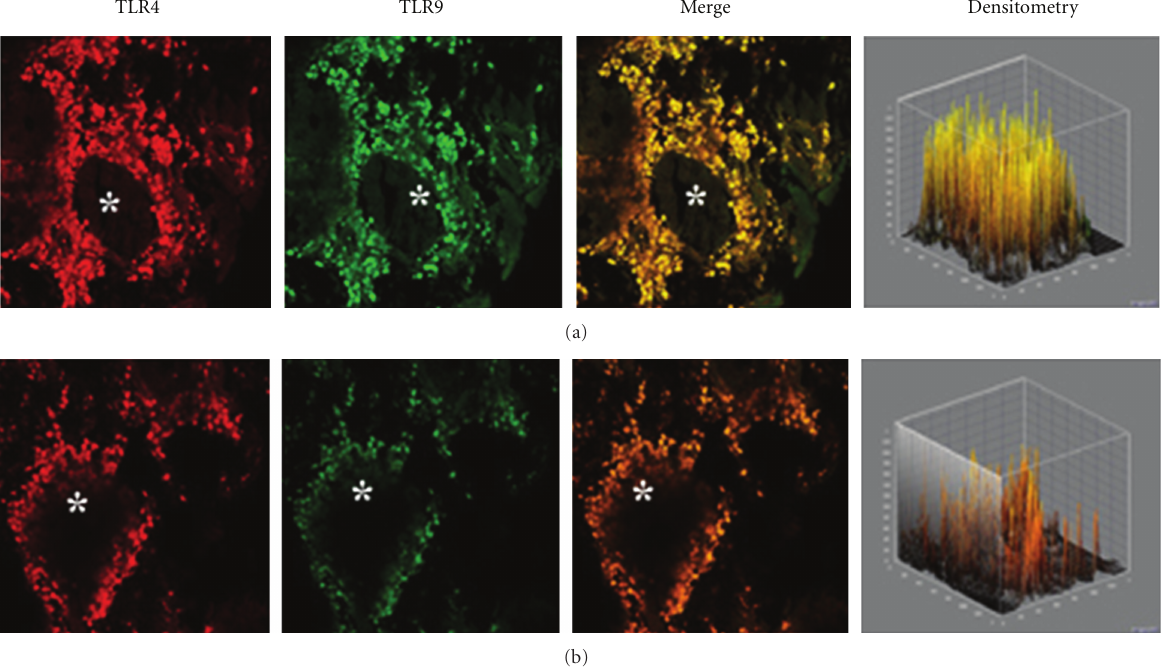
Figure 4: TLR4 and TLR9 expression in vasomotor rhinitis. Confocal analysis showing the coexpression of TLR4 and TLR9 (a) and (b). Note the predominance of the yellow staining indicating the prevalence of the TLR9 expression over TLR4. Asterisk indicates the lumen of a nasal gland. ×